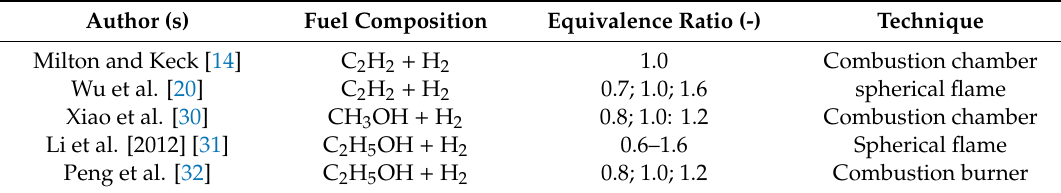
Table 2. List of some of the experimental laminar burning velocity available in the current literature for alkene / hydrogen and alcohol / hydrogen mixtures with air at ambient temperature and